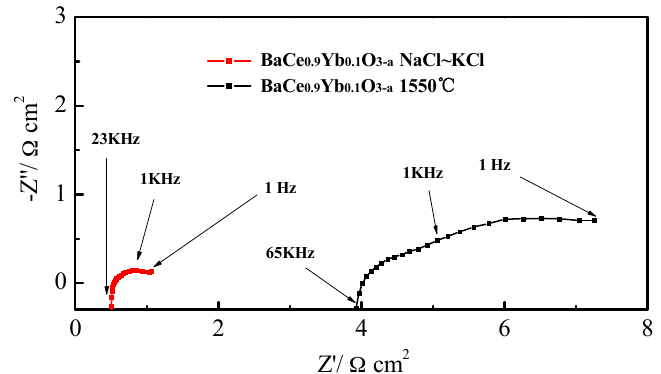
Figure 6. The electrochemical impedance spectroscopy (EIS) of BaCe 0.9 Yb 0.1 O 3 −α (1550 °C) and BaCe 0.9 Yb 0.1 O 3 −α -NaCl~KCl under open-circuit conditions at 700 °C.